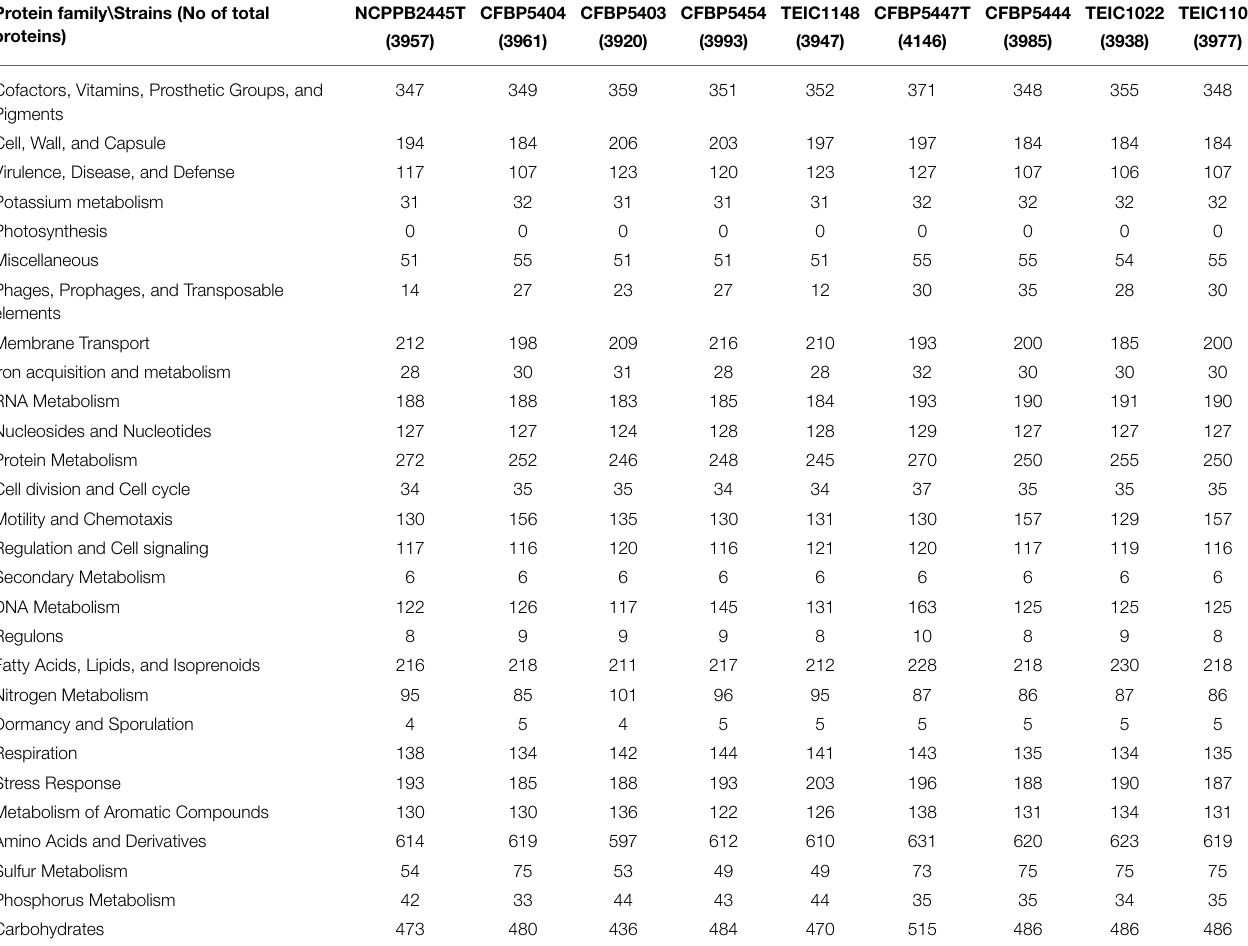
TABLE 4 | Organismal subsystem prediction overviews estimated by the RAST server. Protein family\Strains (No of total